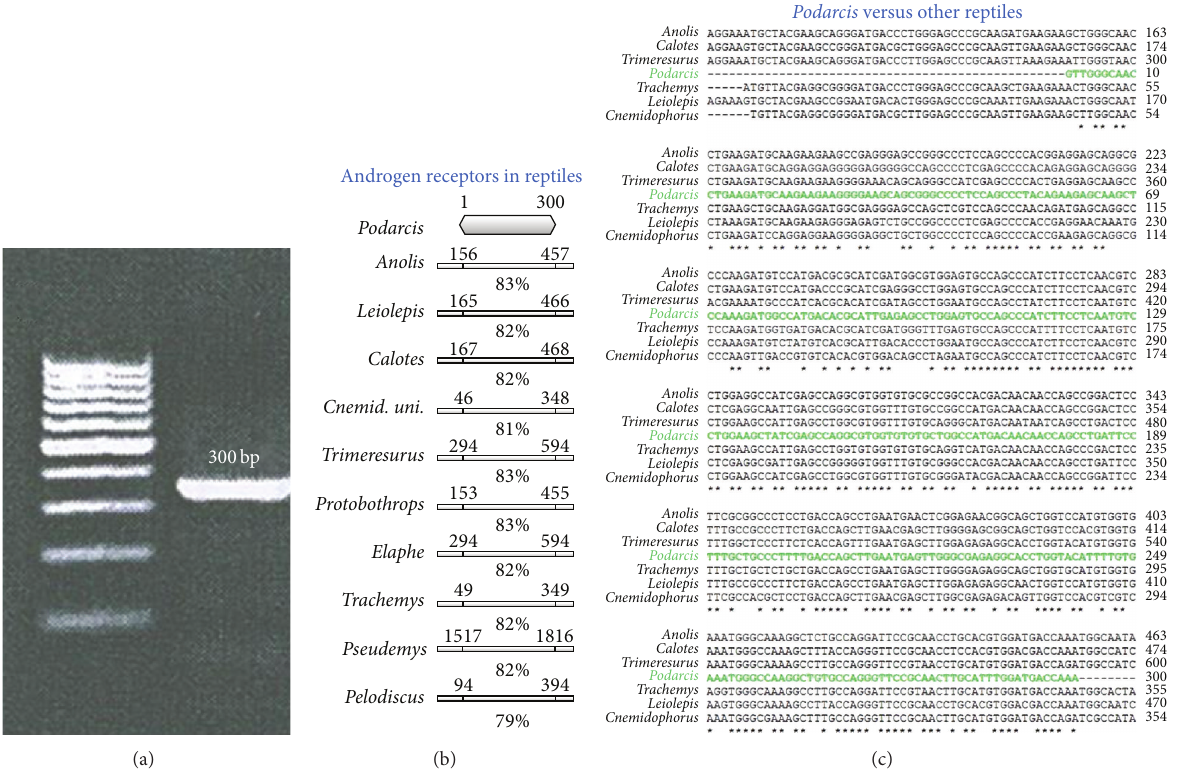
Figure 1: Sequencing of androgen receptor. (a) Agarose gek of RT-PCR on cDNA of Podarcis testis. (b) Similarity of predicted amino acid sequences of many reptiles with Podarcis AR. (c) BLAST alignment of the nucleotide sequence of AR in Podarcis compared to other reptiles as Anolis , Calotes , Trimeresurus , Trachemys , Leiolepis , and